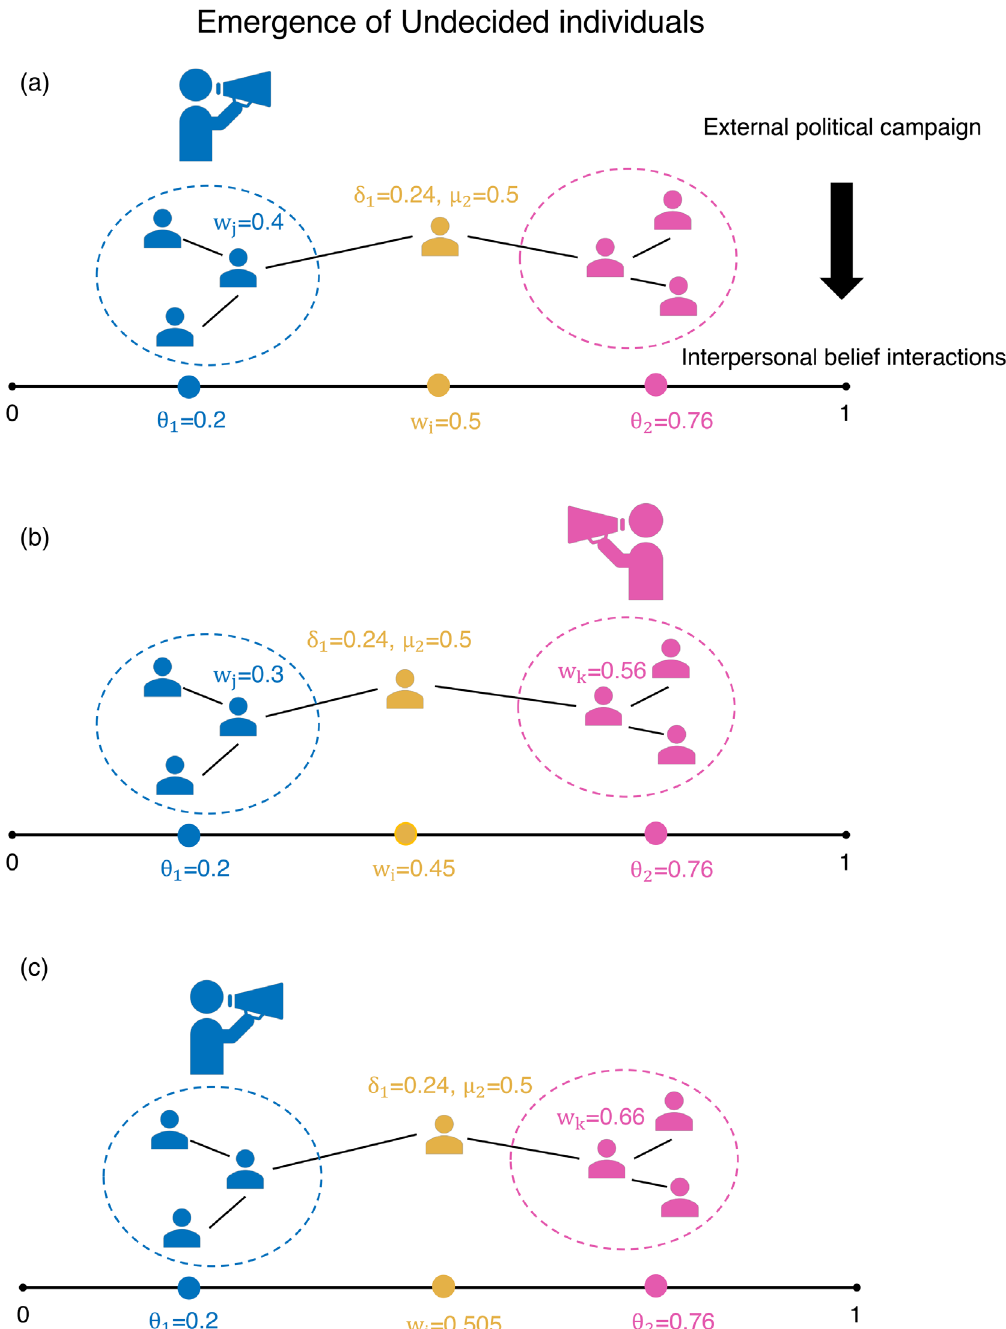
FIG. 14. Emergence of undecided individuals. (a),(b) The undecided individual i updates with viewpoint blue ( θ 1 ) that is beyond its identity scope; therefore, i seeks friend j for interpersonal interaction. (b),(c) The undecided individual i updates with viewpoint red ( θ 2 ) that is also beyond its identity scope and further discusses with friend k